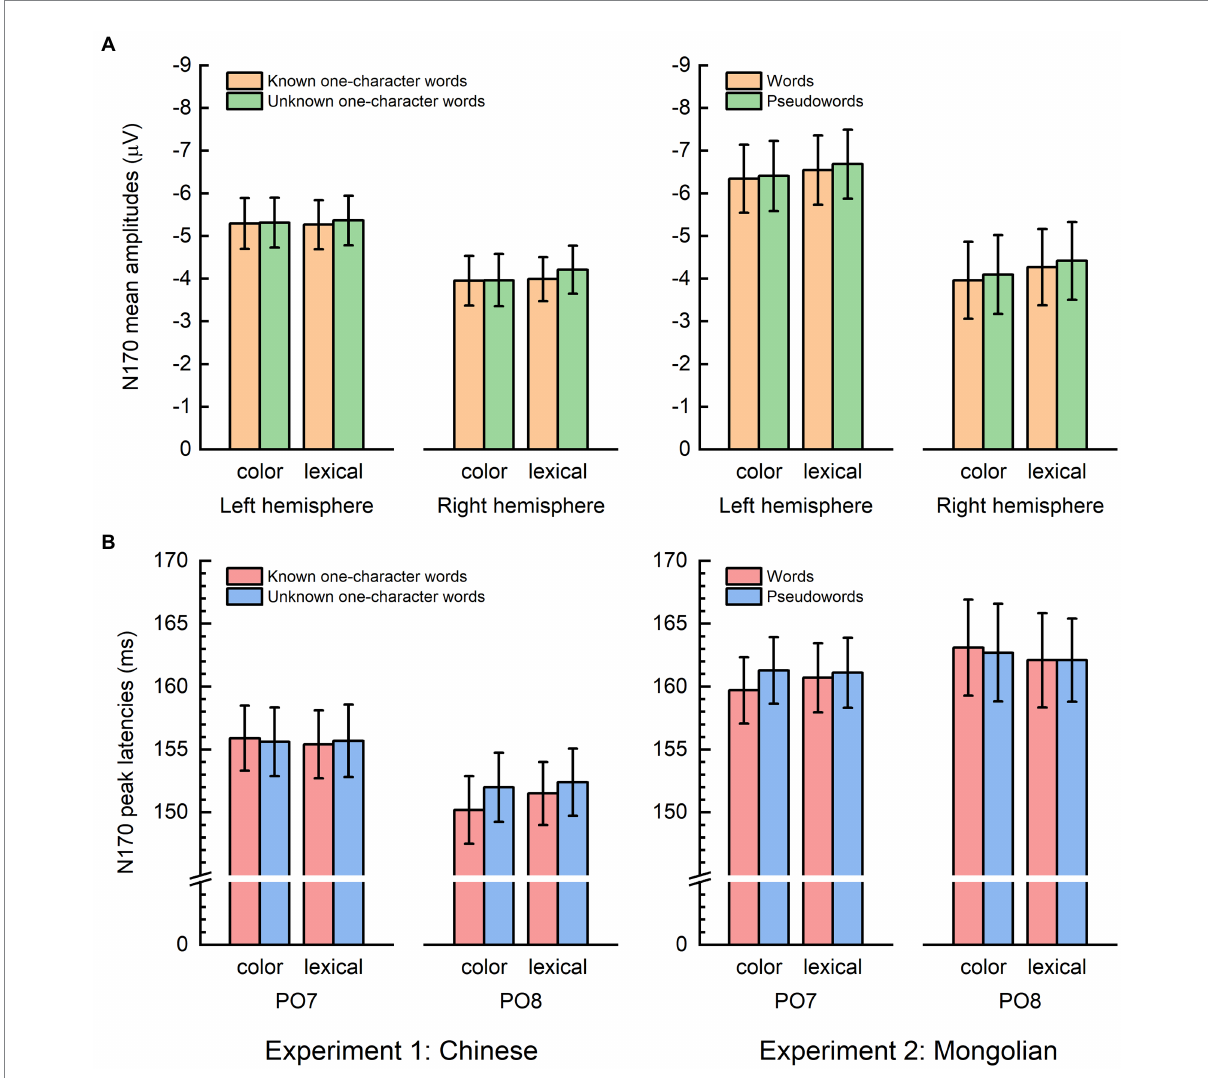
FIGURE 3 Mean N170 amplitudes and N170 peak latencies. (A) The mean N170 amplitudes elicited by lexical items were significantly smaller than those elicited by non-lexical items. The mean N170 amplitudes were significantly larger in the left hemisphere compared with the right hemisphere. (B) The N170 peak latencies were significantly shorter for lexical items than in non-lexical items in the right hemisphere (PO8) for Chinese but not Mongolian. The error bar represents one standard error of the